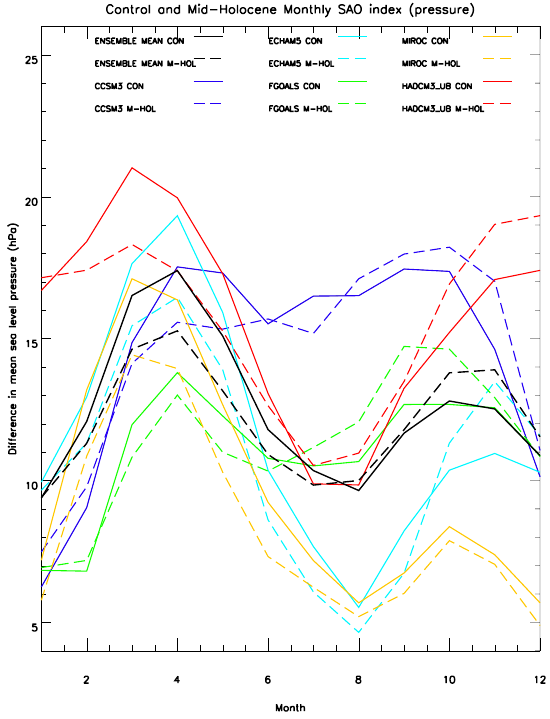
Fig. 8. Another measure of the SAO index ( 1 SLP) for all of the available and stable (see Braconnot et al., 2007) models from the PMIP2 control run (solid lines) and Mid-Holocene runs (dashed lines) (hPa). Refer to Table 1 for more details on each